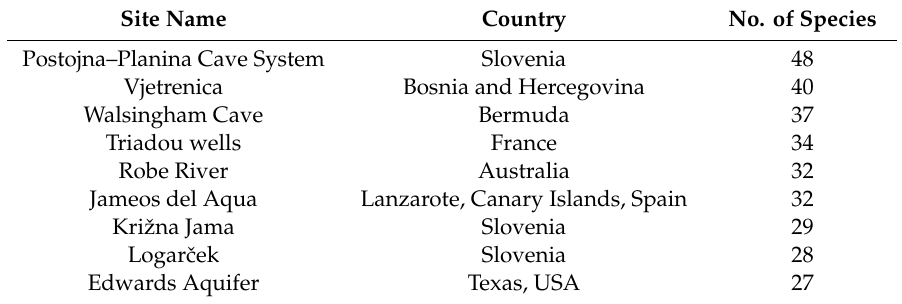
Table 3. Caves and other karst sites with 25 or more obligate aquatic subterranean species (stygobionts). From Culver and Pipan [61],